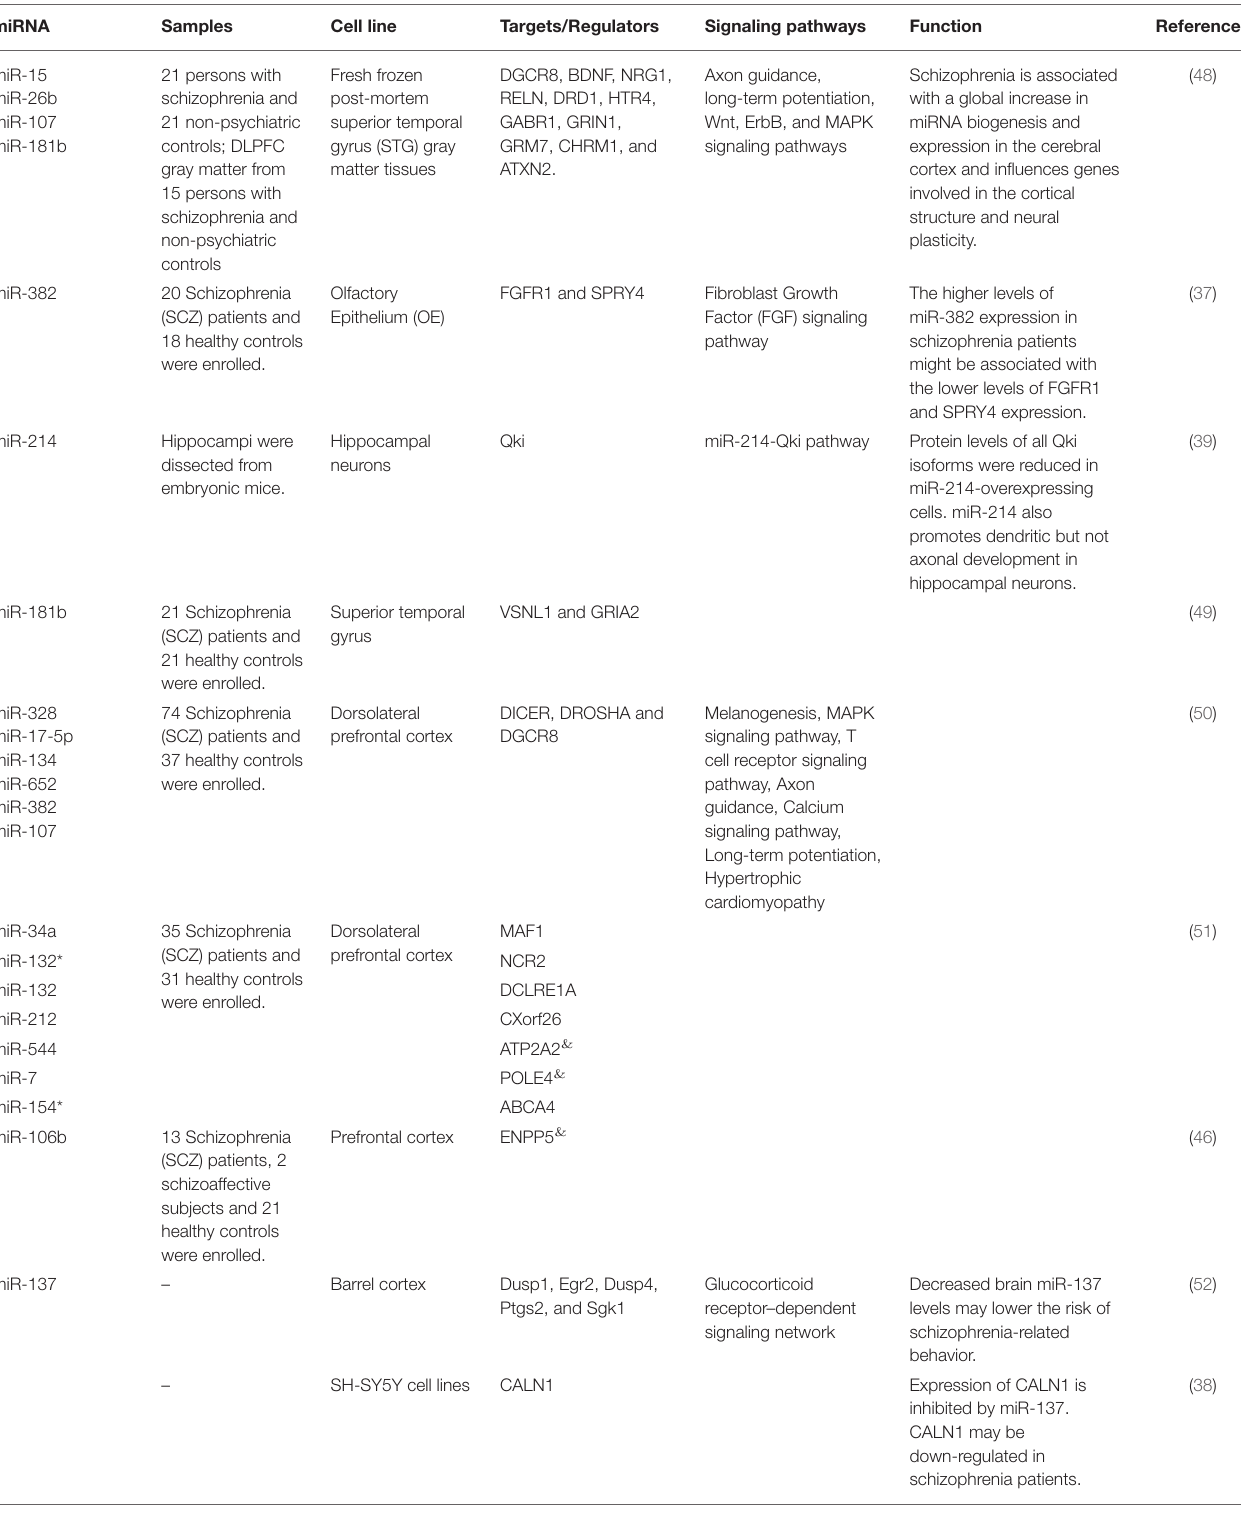
TABLE 5 | Up-regulated microRNAs in schizophrenia (Empty cells show that this information has not been provided in the main articles).